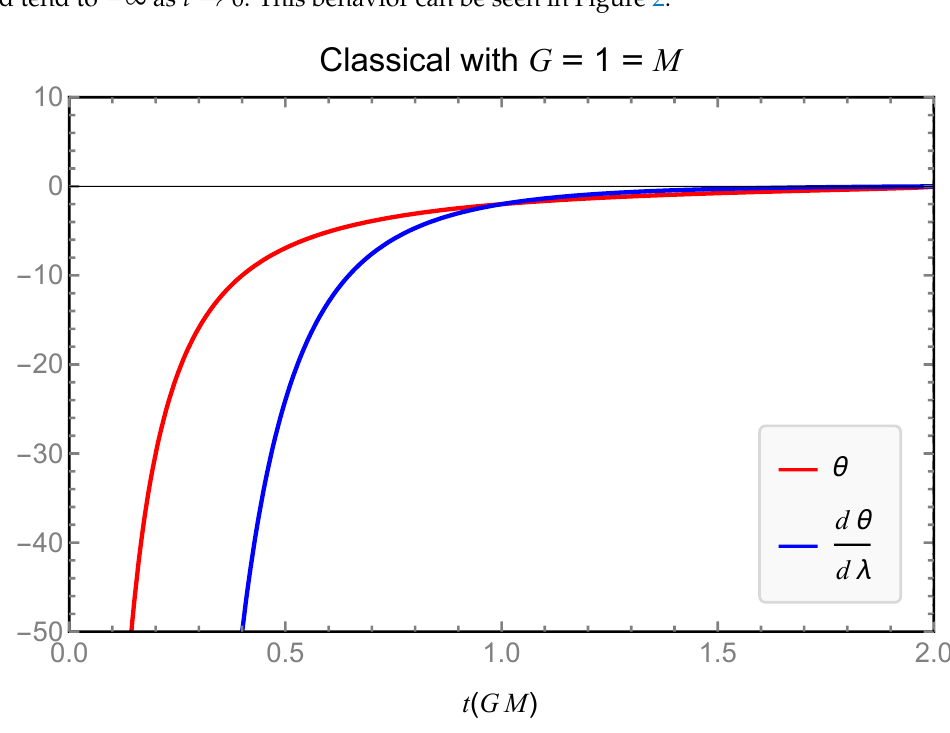
diverge as we approach t → 0. Notice that θ always remains d λ